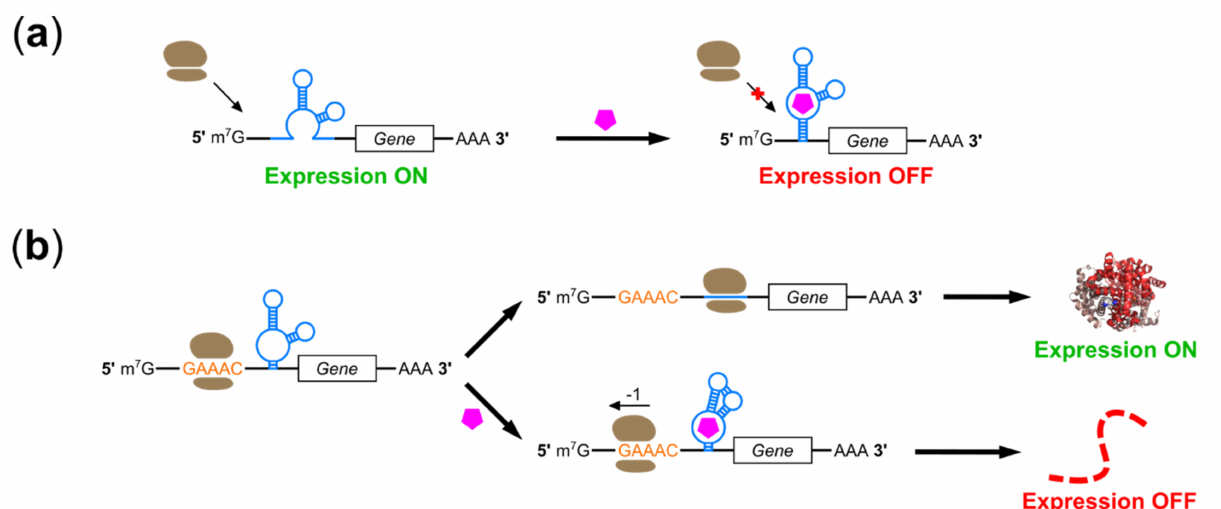
Figure 2. Riboswitches Regulating Translation Initiation and Elongation in Mammalian Cells. ( a ) Translation roadblock. Binding of a ligand (magenta) stabilizes the structure of an aptamer (blue) in the 5 (cid:48) UTR, inhibiting translation complex assembly or procession [79,85,86]. This approach is less effective in mammalian cells than in bacteria or yeast, possibly due to differences in ribosome binding or 40S ribosomal subunit scanning [54,80,83,84]. This mechanism can also be mediated by ligand-responsive oligonucleotides binding in trans [89]. ( b ) Programmed -1 ribosomal frameshifting (-1 PRF). In the absence of ligand binding, ribosomes proceed efficiently through -1 PRF sequences and synthesize functional, in-frame protein products. Ligand binding stabilizes a structured RNA stimulator containing an aptamer (blue), causing -1 ribosomal frameshifting on an upstream slippery sequence (orange) and promoting premature termination or expression of a non-functional, -1 frameshifted protein